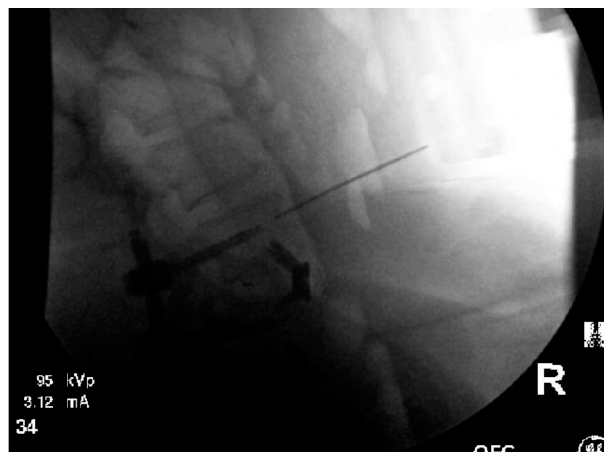
Figure 1: Kirschner wire projecting anteriorly from